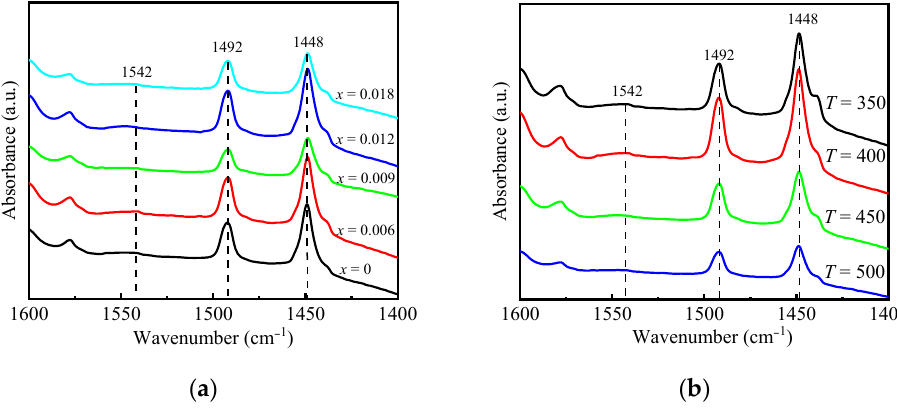
Figure 4. Py-IR spectra of ( a ) AlP 1.1 Zr x -400 and ( b ) AlP 1.1 Zr 0.012 - T samples.